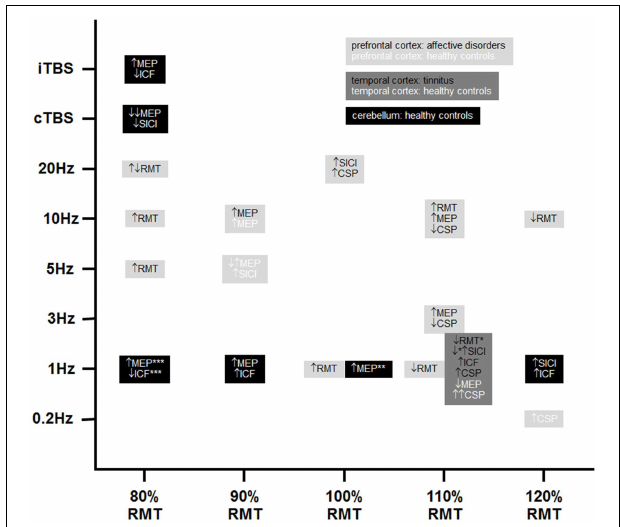
FIGURE 1 | Positive findings of TMS-induced changes in non-motor areas with respect to motor cortex excitability. Please note that black, dark, and light gray represent different stimulation sites and white and black fonts represent healthy controls and patient groups, respectively. ↑ , increases; ↔ , no changes; ↓ , decreases; CSP, cortical silent period; ICF, intracortical facilitation; MEP, motor evoked potential; RMT, resting motor threshold; SICI, short-interval intracortical inhibition; cTBS, continuous theta burst stimulation; iTBS, intermittent theta burst stimulation (8s inter-burst interval); * 22 out of 116 patients received combined frontal and temporal stimulation; ** 40% stimulator output instead of 100% RMT as stimulation intensity; *** 90% active motor threshold over the inion instead of 80% RMT. Please note that increases in SICI means increases in inhibition and concomitantly a numeric decrease in the raw data.